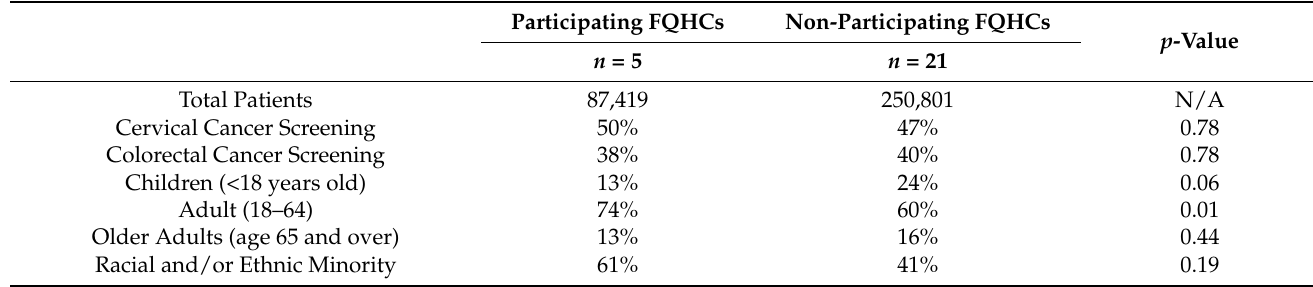
Table 1. Comparison of average patient characteristics among participating ( n = 5) versus